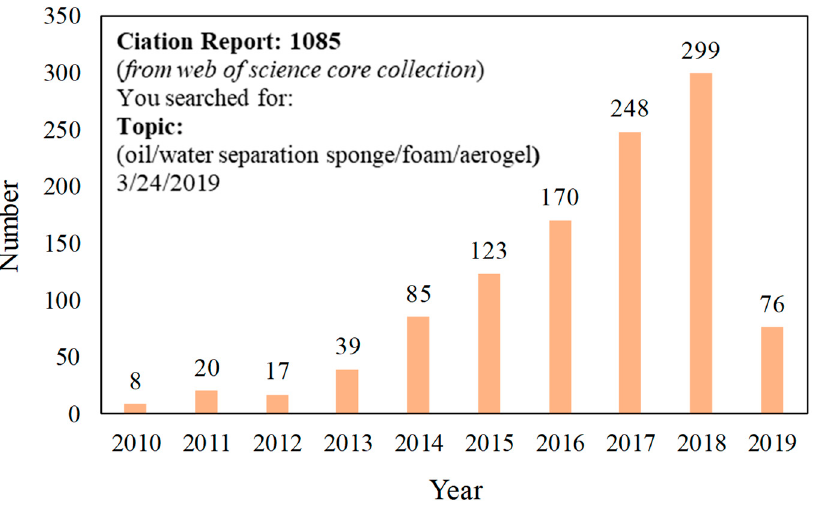
Figure 3. The published articles from 2010 to February 2019 indexed in ISI Web of Science by searching “oil/water separation sponge/foam/aerogels”. “oil / water separation sponge / foam /